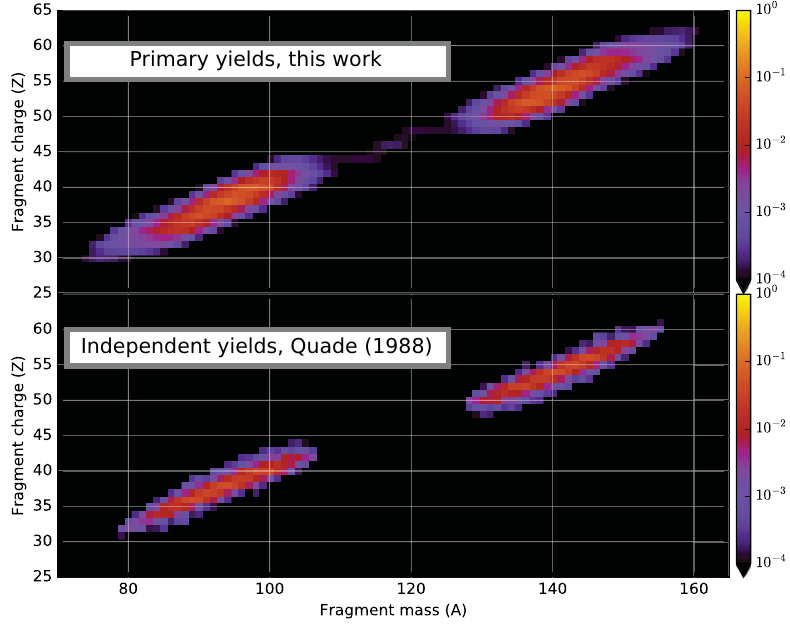
Figure 4. Correlated yields in mass and charge for the reaction 233 U(n,f) obtained with our work before prompt emissions (upper panel) and from experimental data after prompt neutron emissions (lower panel).